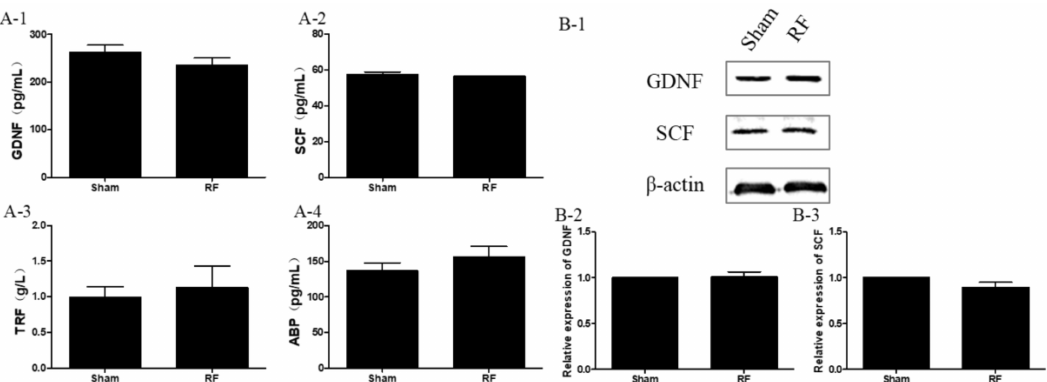
Figure 5. The effect of one-month 220 MHz pulsed modulated RF exposure on the secreting function of testicular Sertoli cells (SCs) in SD rats. ( A ) The results of ELISA. ( A-1 ) Glial cell line-derived neurotrophic factor (GDNF); ( A-2 ) Stem cell factor (SCF); ( A-3 ) Transferrin (TRF); ( A-4 ) Androgen binding protein (ABP). N = 12 for each group. ( B - 1 ) The results of Western blotting. ( B - 2 ) Relative expression of GDNF; ( B - 3 ) Relative expression of SCF. N = 3 for each group. The values were expressed as means ± SEM and were analyzed by student t -test. Mean differences were no significant ( p >